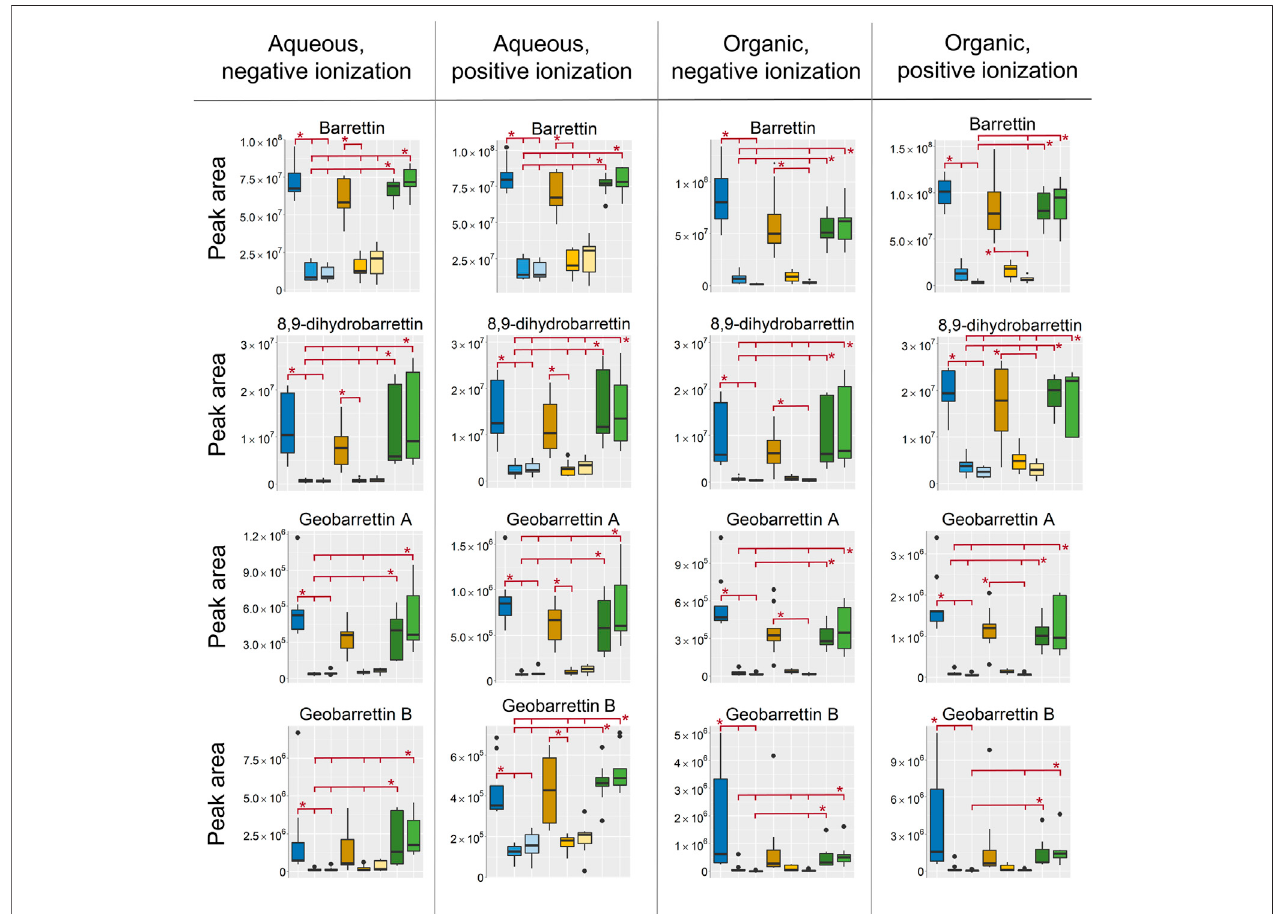
FIGURE6| Box-plotsofpeakareas( y -axis)ofbarrettin,8,9-dihydrobarrettin,geobarrettinAandgeobarrettinB,toptobottomrow,inthefourrespectivedatasets, fromlefttoright.EtOHextr.1(darkblue ),EtOHextr.2(blue ),EtOHsp.(lightblue ),MeOHextr.1(darkorange ),MeOHextr.2(yellow ),MeOHsp.(lightyellow ),frozen(darkgreen ),and fl ashfrozen(green ).Statisticalsigni fi cance( p < 0.05)ismarkedby*intherespectivebox-plots,all p -valuesfromtheKruskalWallisand Nemenyi post-hoc testing can be found in supplementary data, Supplementary Tables S6 – S9